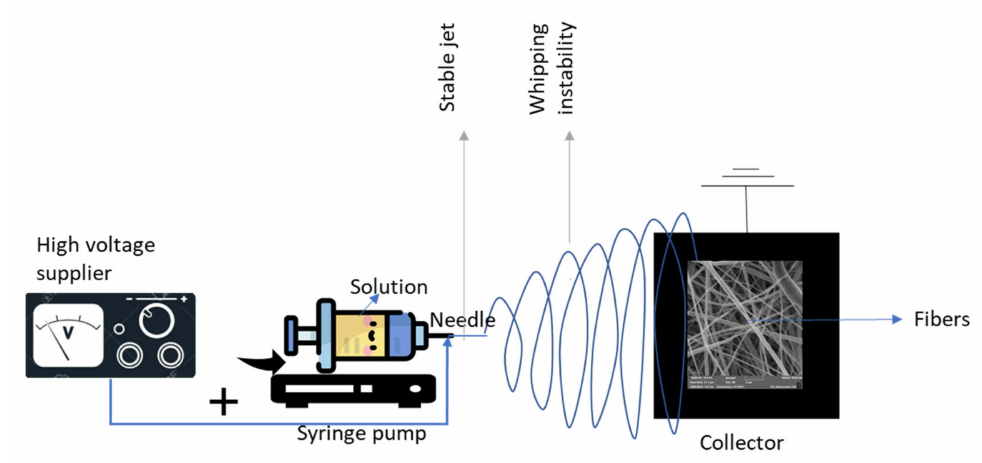
Figure 2. Electrospinning setup. The liquid is extruded from the spinneret during electrospinning, producing a pendant droplet due to surface tension. When a droplet is electrified, electrostatic repulsion between surface charges with the same sign deforms it into a conical shape known as the Taylor cone, from which a charged jet is released. As soon as the electric field reaches a critical value (where the repulsive electric forces overcome the surface tension forces), a charged solution jet is ejected from the tip of the Taylor cone. Because of bending instabilities, the jet initially extends in a straight line and subsequently undergoes severe whipping